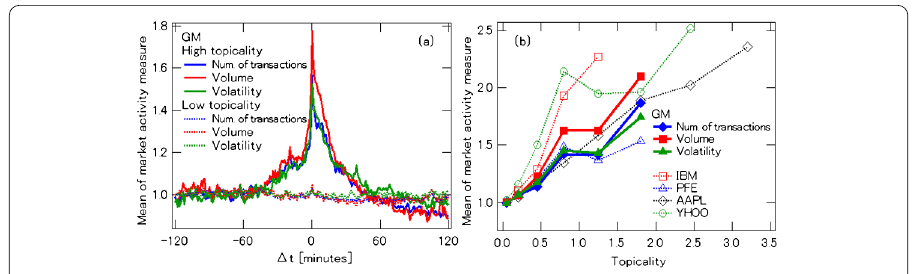
Figure 7 Relationship between topicality of news and market reaction. ( a ) Response of GM stock to news with high and low topicality. ( b ) Relationship between news topicality and market activity three minutes after the news. The solid (dashed) lines in ( a ) show the level of market activity when the topicality measure is above (below) the average. For IBM, PFE, AAPL, YHOO in ( b ), the market activity indicator is the average of the three indicators (number of transaction, transaction volume, and price